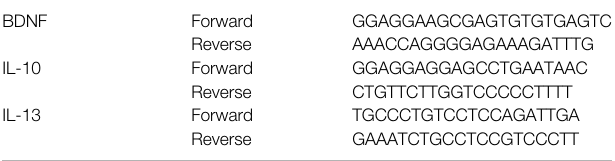
TABLE 3 | Primer sequences used for ChIP-qPCR experiments BDNF